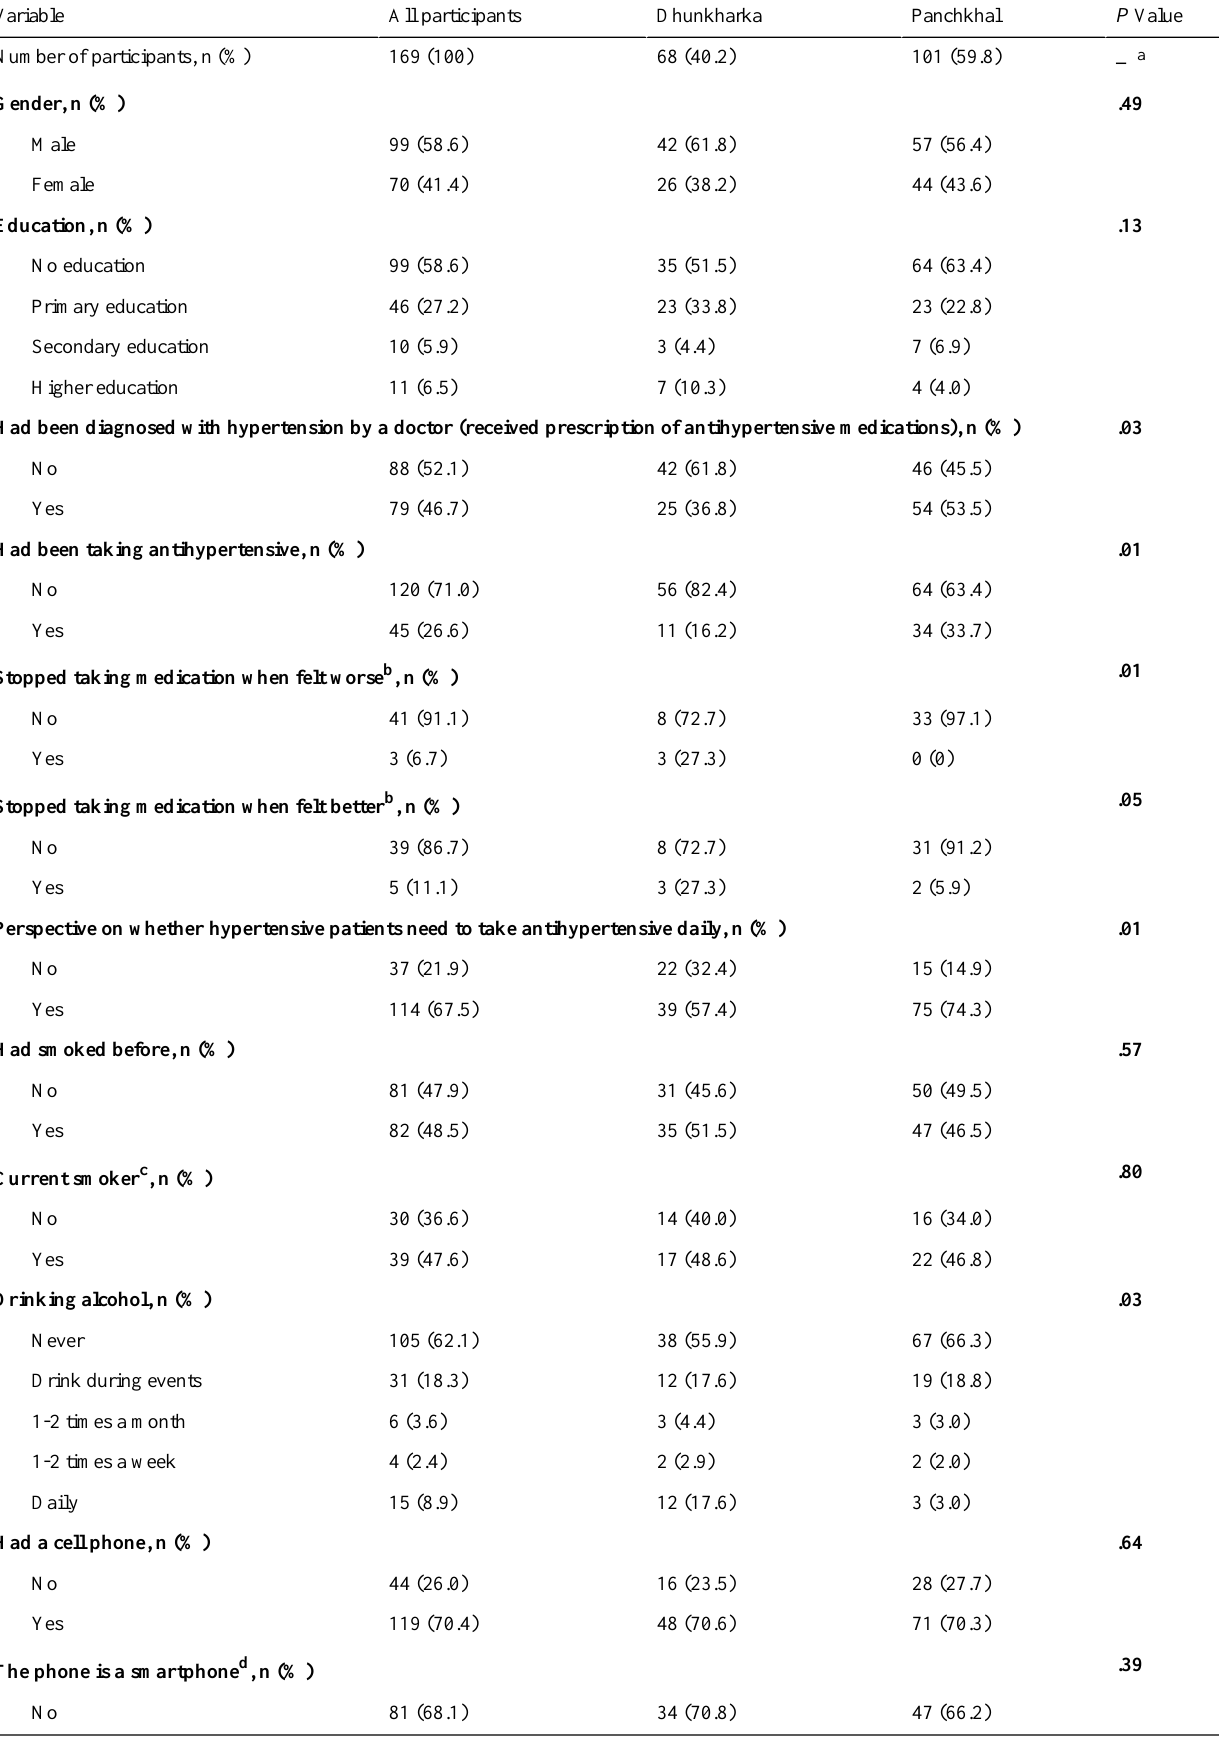
Table 2. Baseline characteristics of the sample selected into Phase III.